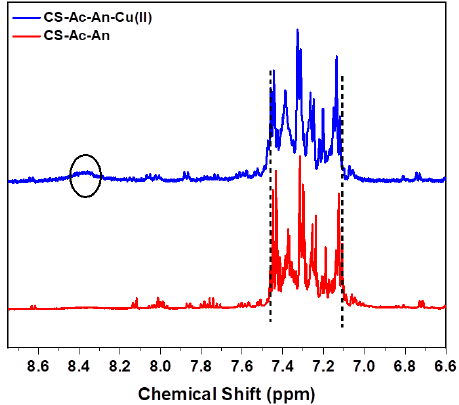
Figure 4. 1 H-NMR spectra before and after adsorption. Downfield shifts and spectral broadening of the aromatic region upon formation of a N–Cu(II) complex is